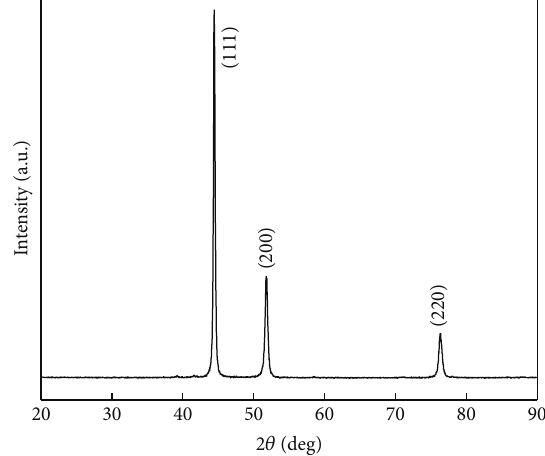
Figure 1: XRD pattern of room-temperature prepared Ni nanopar-